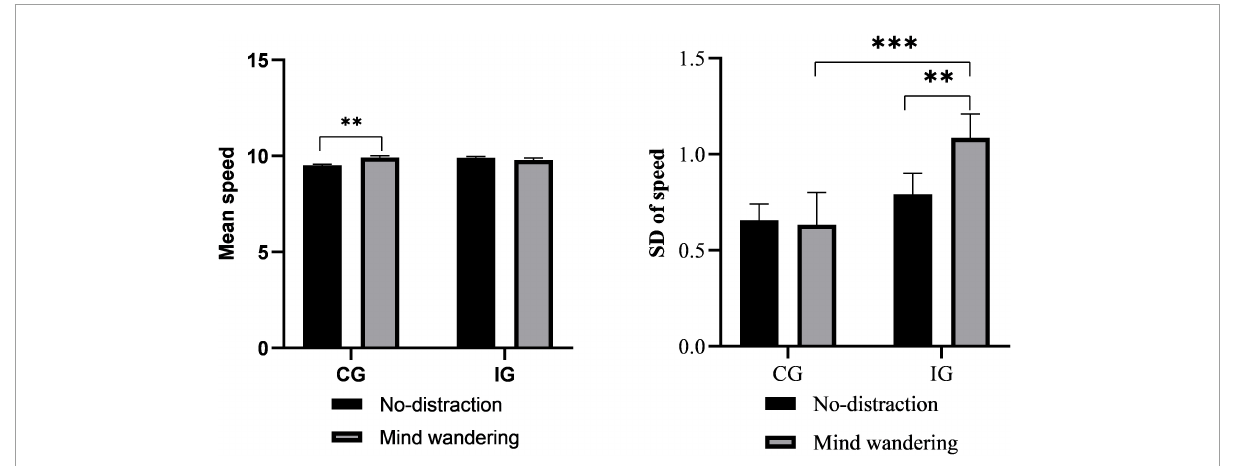
FIGURE1 The effect of mind wandering (MW) on speed. Error bars represent the standard error. ∗∗∗ P < 0.001; ∗∗ P < 0.01; ∗ P < 0.05. MW, mind wandering; SD, standard